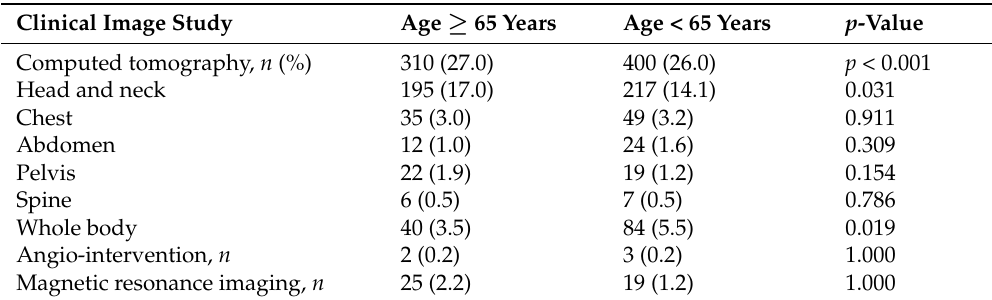
Table 3. Image studies of younger and elderly